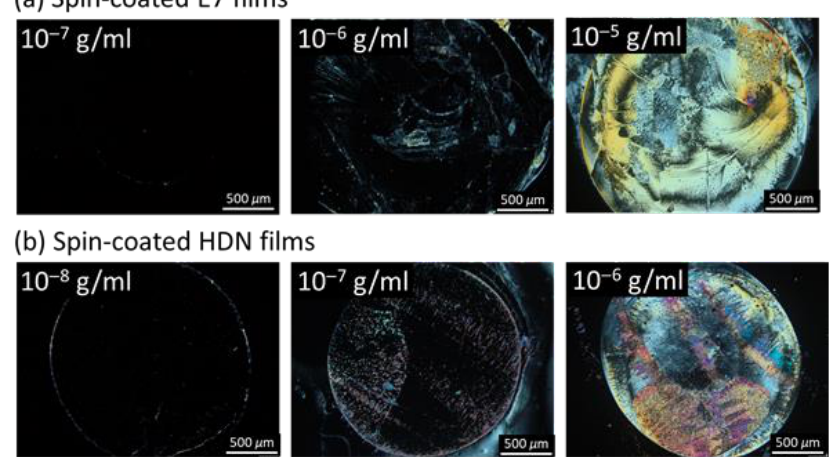
Figure 7. Polarized optical textures of spin-coated E7 and HDN films in the presence of the anti- CA125 antibody. The nematic LCs ( a ) E7 and ( b ) HDN were spin-coated on DMOAP-coated substrates immobilized with the anti-CA125 antibody at concentrations ranging from 10 − 8 to 10 − 5 g/mL. Scale bar, 500 µ m.